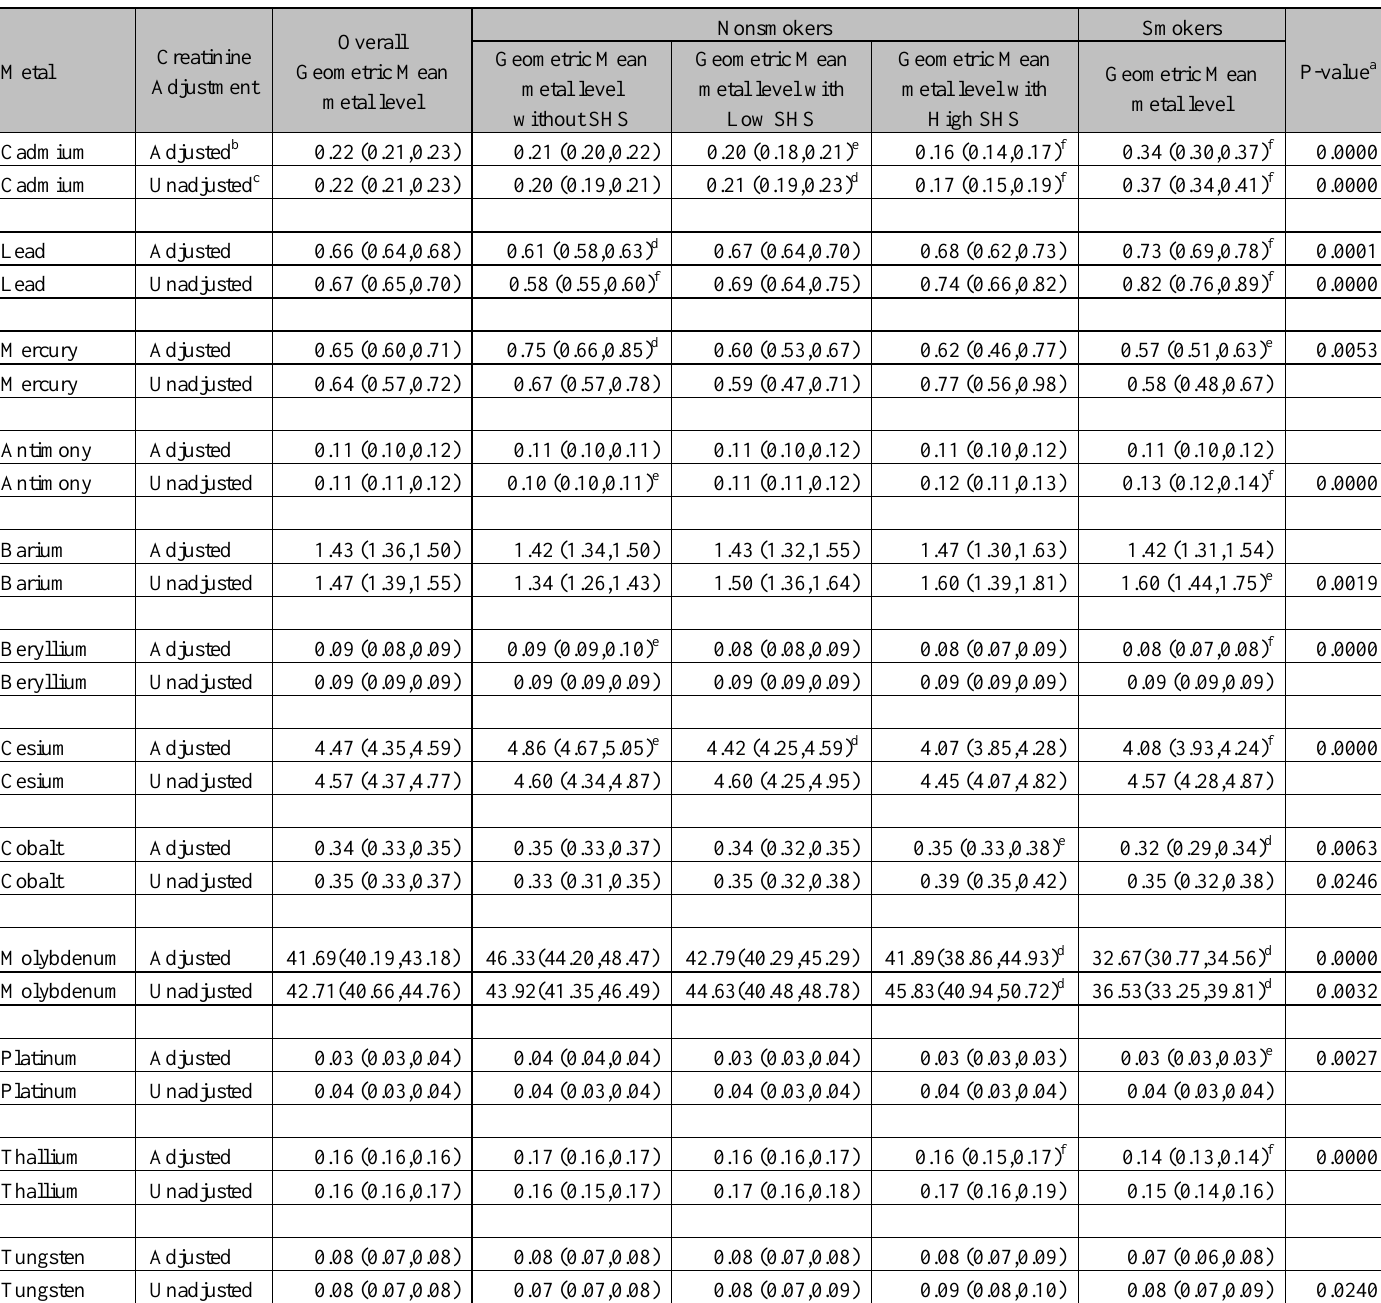
Table 2. Geometric Means and P-values Overall and by Level of Smoke Exposure for 12 Urinary